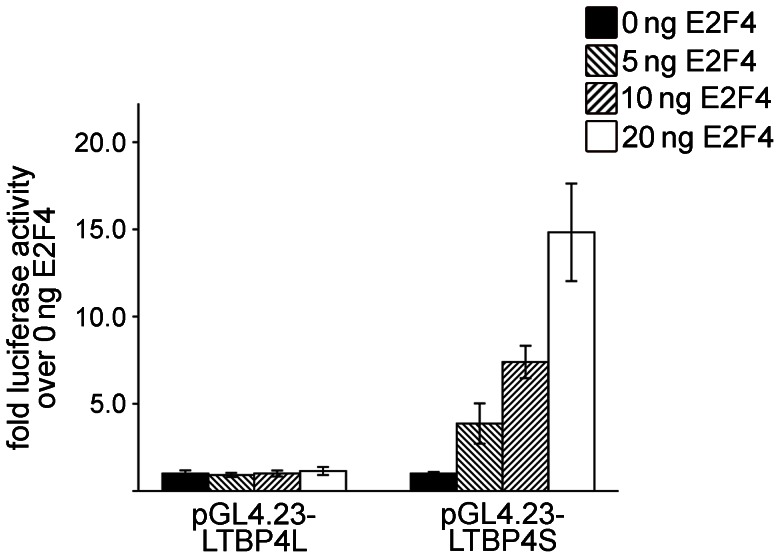
E2F4 acts as a potent regulator of LTBP4S expression in combination with other regulatory elements.HEK293 cells were transiently transfected with pGL4.23-LTBP4L or pGL4.23-LTBP4S and a Renilla luciferase expression vector for normalization. Cells were also co-transfected with different concentrations of an E2F4 expression vector. After 24 h cells were lysed and luciferase activities were determined. Experiments were repeated at least 3 times and the mean value was calculated. Data are presented ± standard deviation.